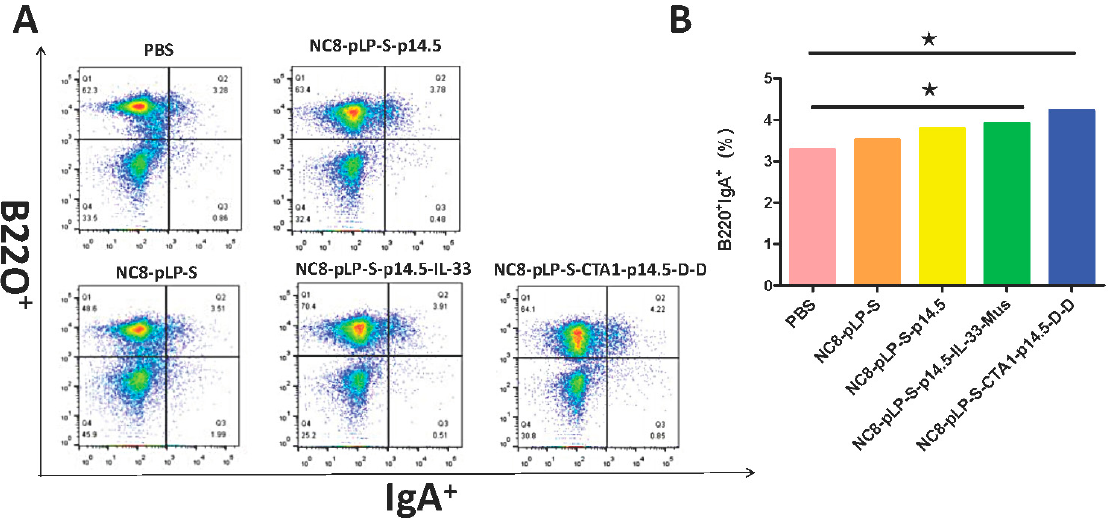
Figure 4. Flow cytometry to detect IgA secretion. ( A ) Changes in B220 + IgA + in mouse PPs; ( B ) Statistical histogram of B220 + IgA + changes in mouse PPs. The secretion of B220 + IgA + in descending order is the CTA1-DD adjuvant group, IL-33 adjuvant group, single antigen group, empty vector group and the control group. * p < 0.05 compared with PBS group.